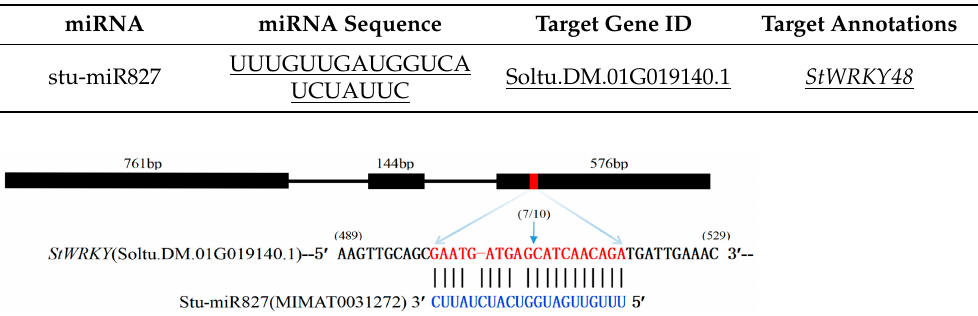
Table 2. Predicted target gene of stu-miR827.